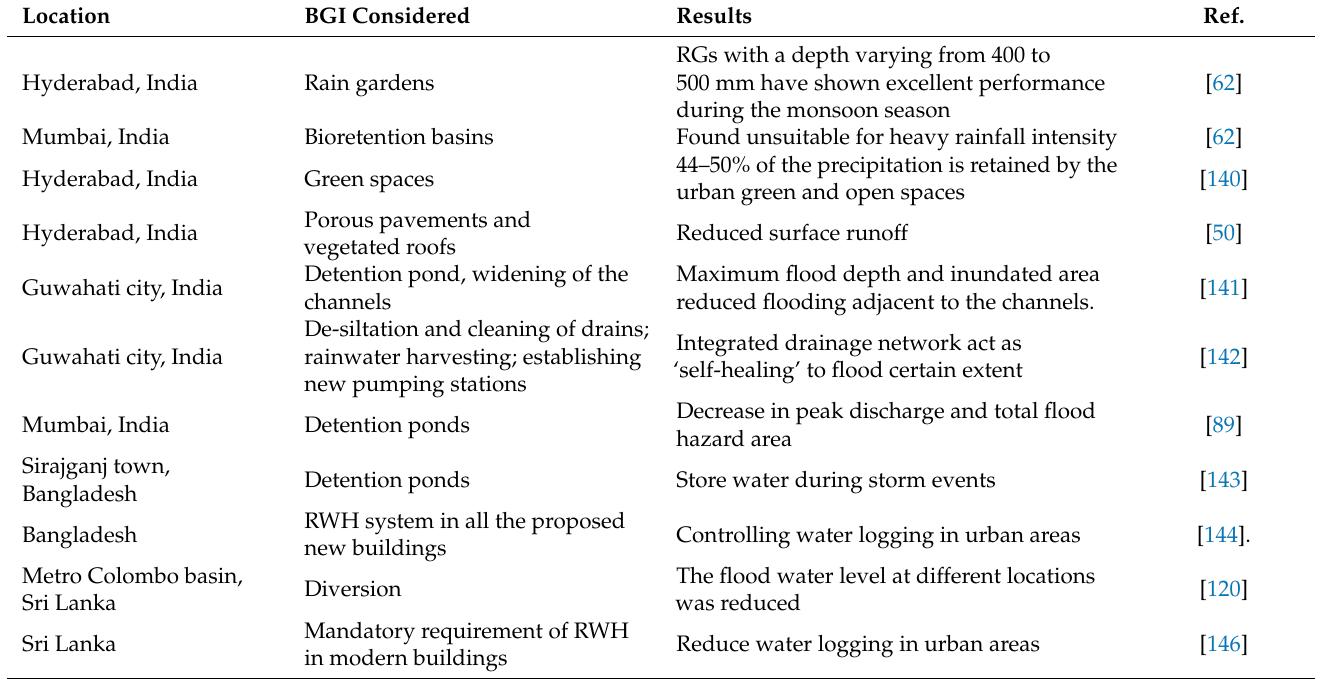
Table 2. Application of structural measures in urban flood management in South Asian cities. Results